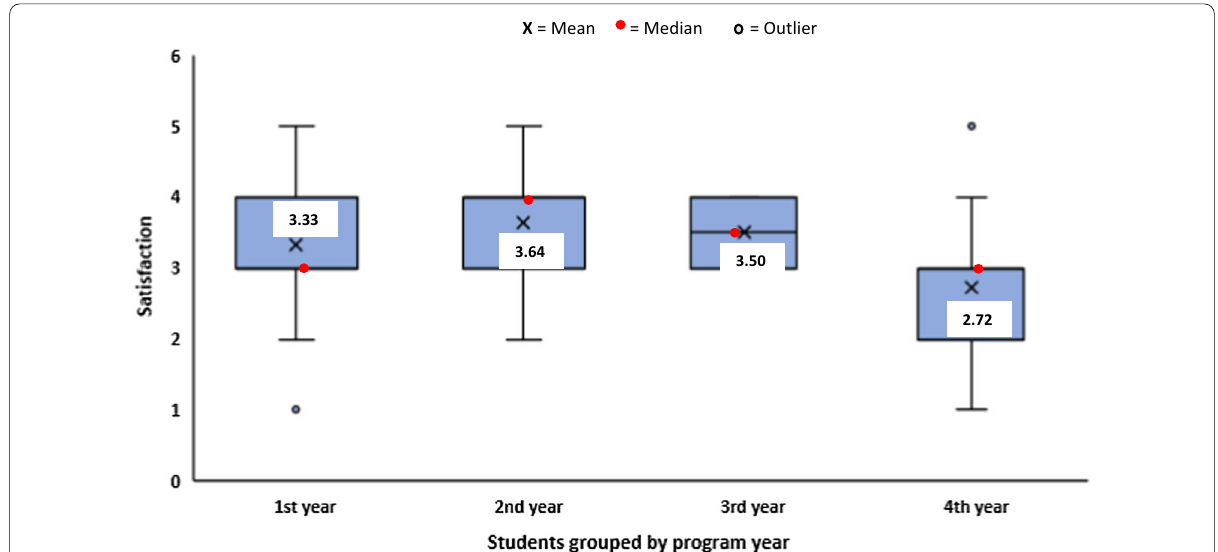
Fig. 6 Box plot to demonstrate and compare student’s satisfaction, on a five-point scoring system, with the performance of the institution in managing educational processes during the lockdown, grouped by program year. In each box, the horizontal border represents the first and third quartiles of awarded marks, upper and lower whiskers represent the highest and lowest awarded marks for each cohorts, respectively, and interquartile range (IQR) rule was used to identify outliers, where 1